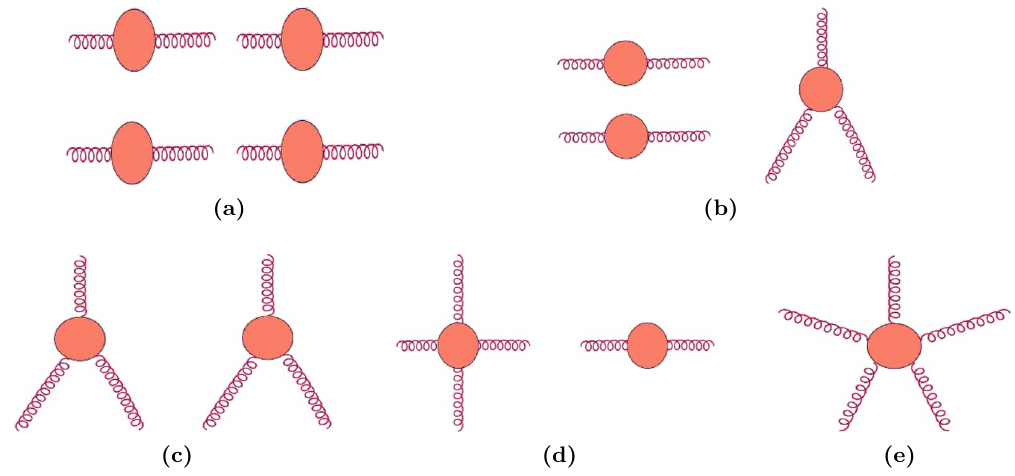
Figure 5. Combinations of connected correlators that can form Cwebs at four